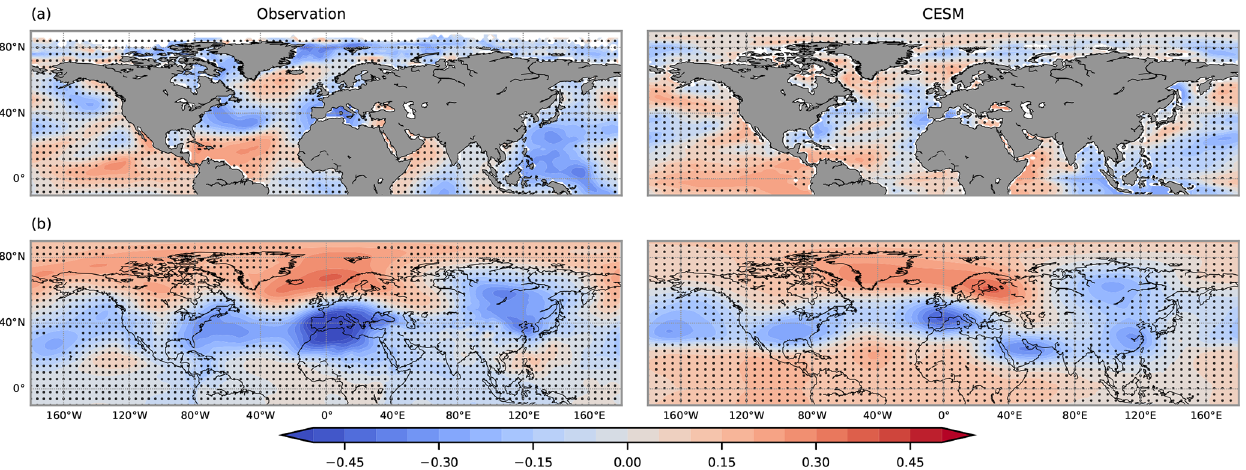
Figure 4. Pearson correlation coefficients between the scPDSI and anomalies of (a) sea surface temperature from ERSST v5 and (b) geopo- tential height at 850hPa from the CR20 for the observation (left) and CESM (right) during the period of 1901–2000CE. The linear trends of variables are removed before applying the correlation. Black dots on the maps show the regions where correlations are statistically not significant at 5% confidence